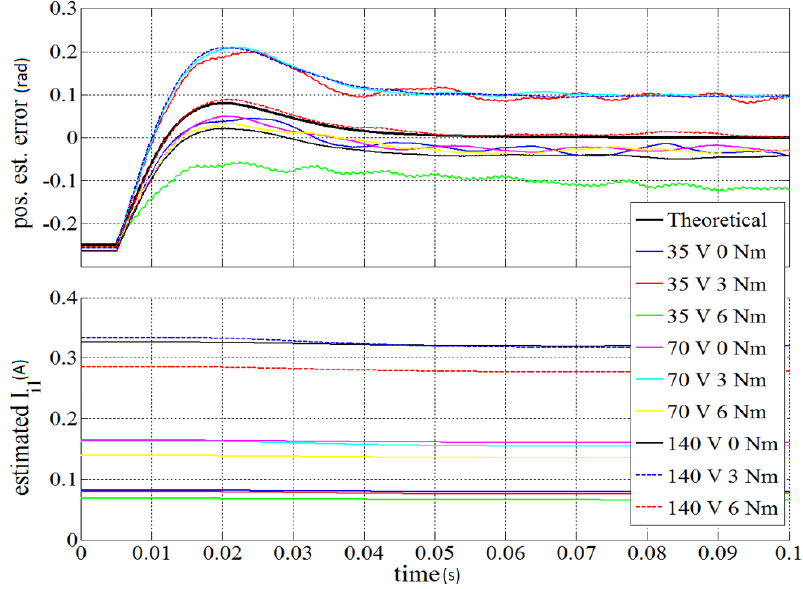
Energies 2019 , 12 , x FOR PEER REVIEW Figure 9. Step response of position tracking loop (motor #1). Figure 9. Step response of position tracking loop (motor #1).